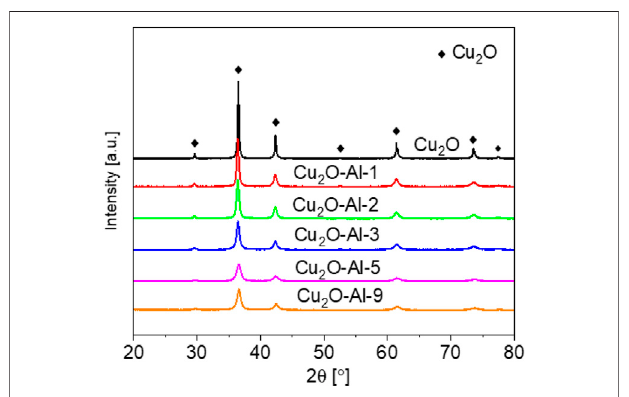
FIGURE 2 | XRD patterns of Cu-Al samples.